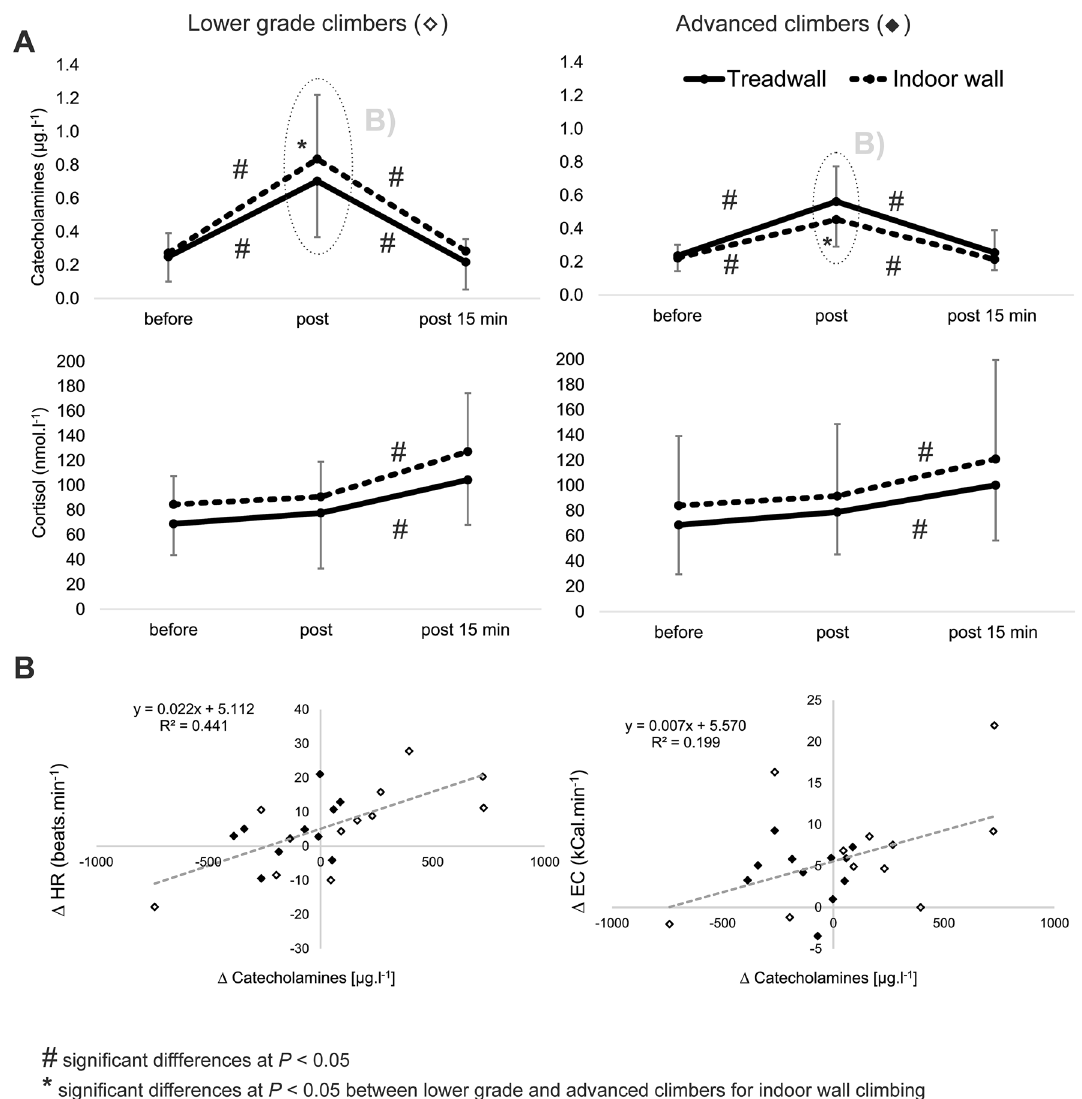
Figure 3. ( A ) Mean (± s ) cortisol and catecholamine concentration before, immediately post and 15 min after climbing on the treadwall and in climbing gym in lower grade and advanced climbers; ( B ) Changes in heart rate (HR) and EC (energy cost) between treadwall (0 on the graph) and indoor wall climbing (full and empty quadrangles on the graph) in relationship with catecholamine changes. Empty and full quadrangles represent lower grade and advanced climbers, respectively.